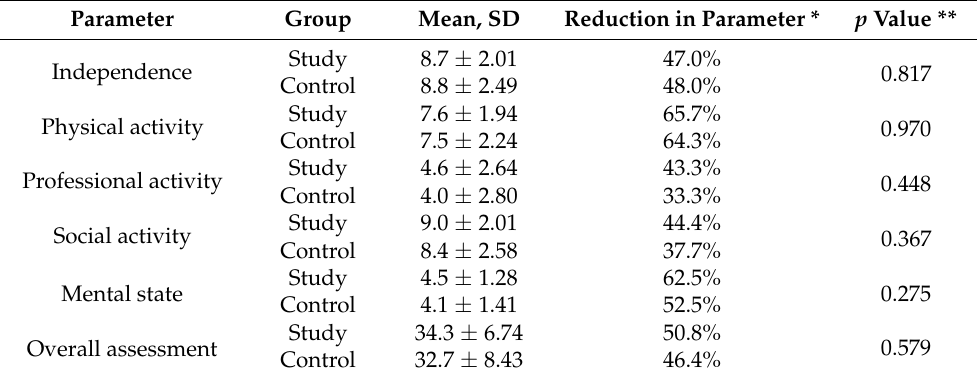
Table 4. Subgroup and overall QoL scores in patients with brain tumors with and without epilepsy.